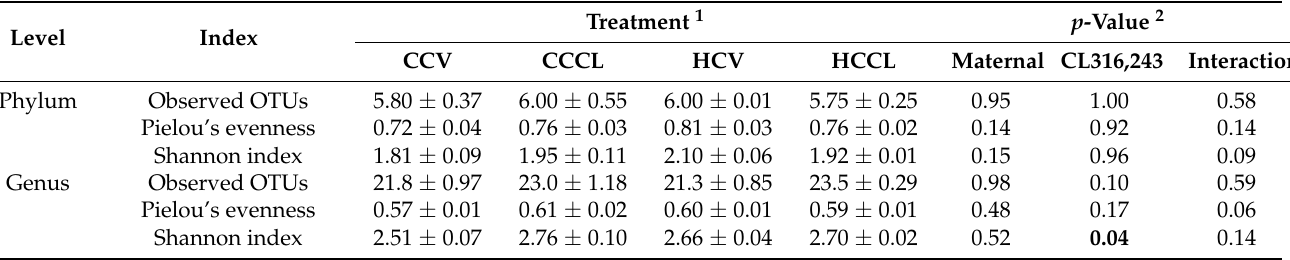
Figure 1. Overview of the conducted studies. In Study 1, CCV = offspring from control diet-fed dams treated with vehicle (n = 5), CCCL = offspring from control diet-fed dams treated with CL316,243 (n = 5), HCV = offspring from high fat diet-fed dams treated with vehicle (n = 4), HCCL = offspring from high fat diet-fed dams treated with CL316,243 (n = 4). In Study 2, mice were exposed to either 8 °C (n = 5) or 30 °C (n = 5) for 7 days. Table 1. Alpha diversity indices at the phylum and genus levels